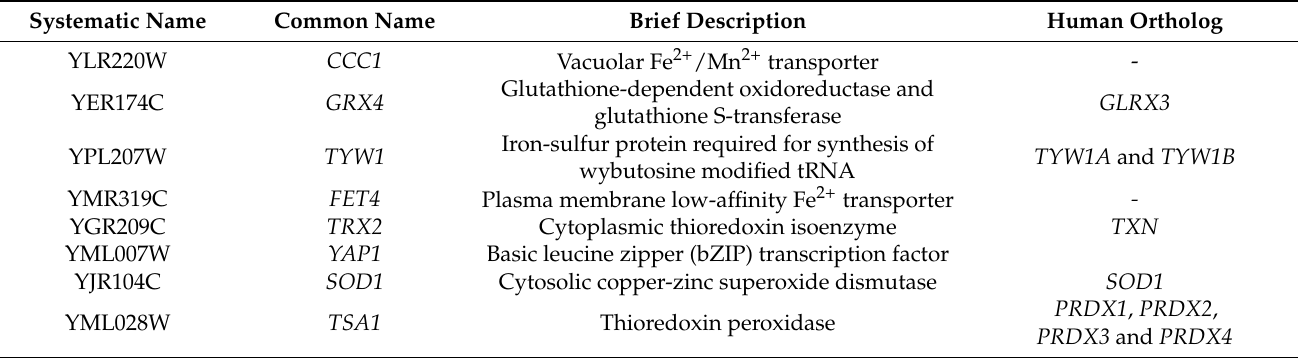
Table 2. List of genes involved in iron overload and oxidative stress analyzed in this study. Systematic and common gene names, a brief description of function, and human orthologues are